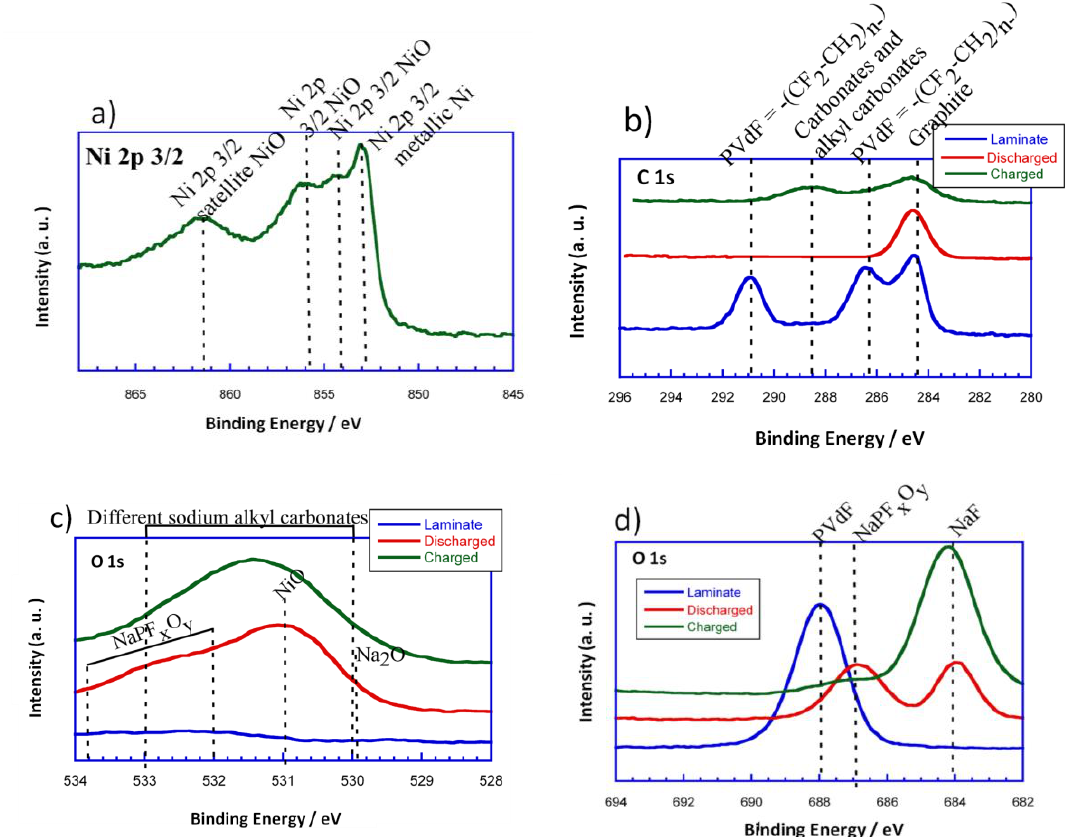
Figure 8. Ni 2p 3/2 ( a ), C 1s ( b ), O 1s ( c ), F 1s ( d ) photoelectron spectra for the powder, the initial laminate and discharged and charged electrodes.